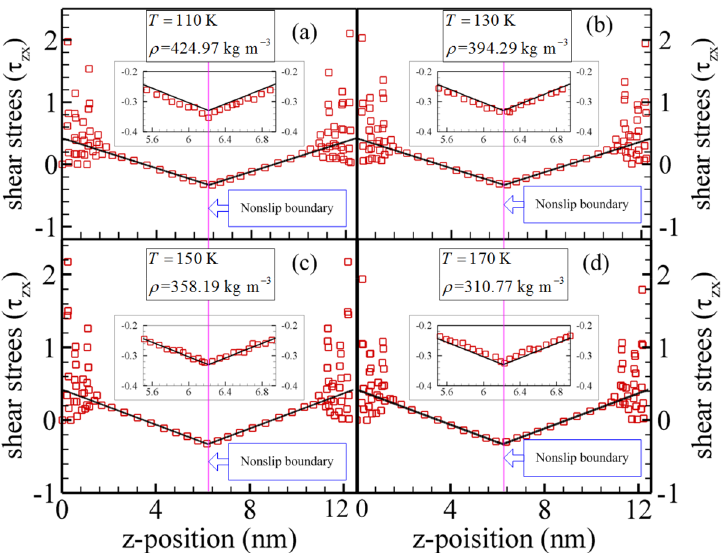
Figure 4. Shear stress profile from mixture boundary Poiseuille flow model via NEMSMD simulations (red squares) and theoretical value (black solid lined).